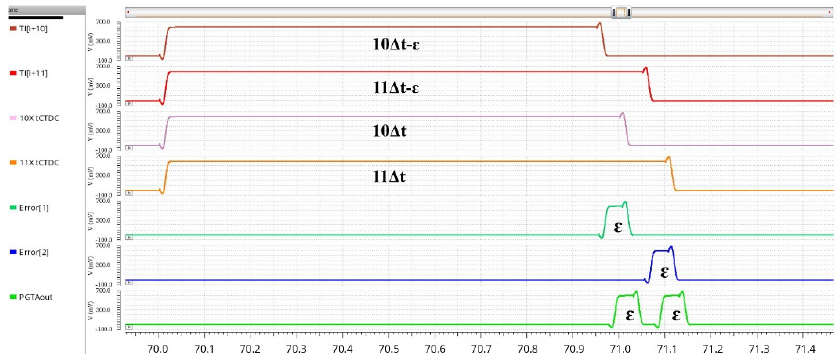
( b ) Figure 11. ( a ) Structure of the XOR gate; ( b ) structure of the OR gate in the PGTA. 3.2.3. FTDC Since the PGTA outputs a serial discrete pulses, a FTDC based on a gate delay line (GDL) is used to quantize the amplified residues. The structure of FTDC is shown in Fig- ure 12. The PGTA output is used as an Enable signal to control the propagations of a LP signal in the GDL. The statement of each delay unit in the GDL is read by the encoder as the output of the FTDC. With the control of LP and LP_n signal, M F9 and M F10 is used to reset the statement of the FTDC after quantization. According to the descriptions in Sec- tion 3.2.1, the sizes of the MOSFETs are carefully designed to ensure that the delay units in the FTDC maintain a low temperature sensitivity. The resolution of the FTDC is about